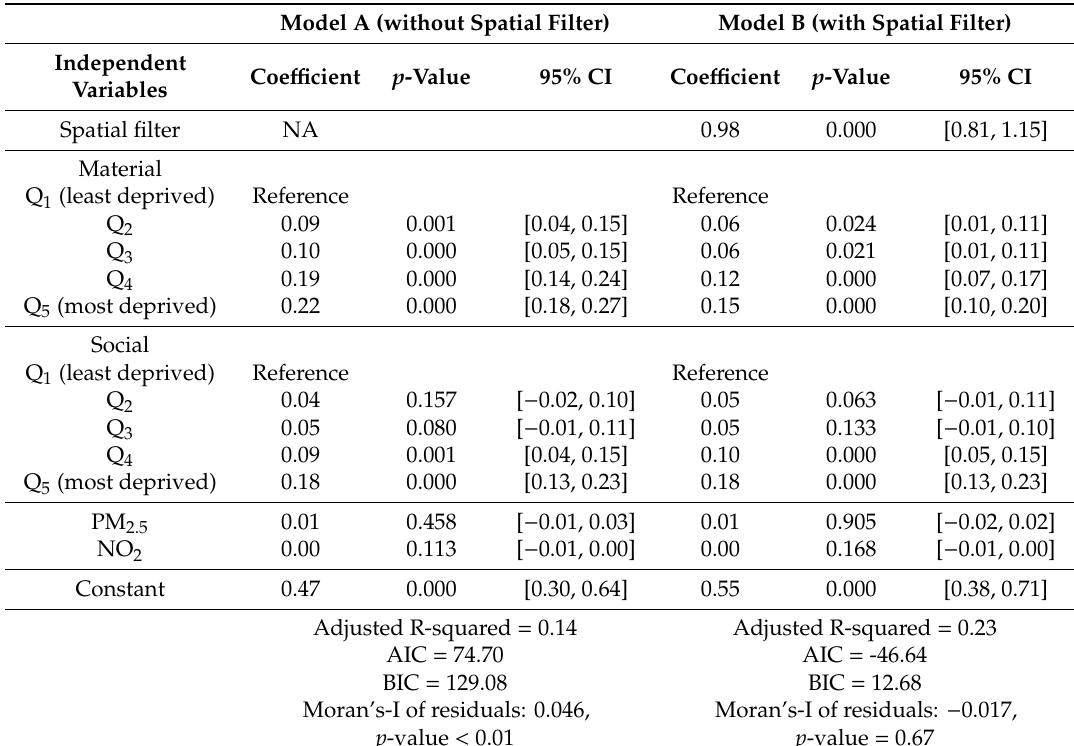
Table 3. Multivariable linear regression models (without and with spatial filter) on the association between smoothed-SPR and independent variables without and with spatial filter for Edmonton.